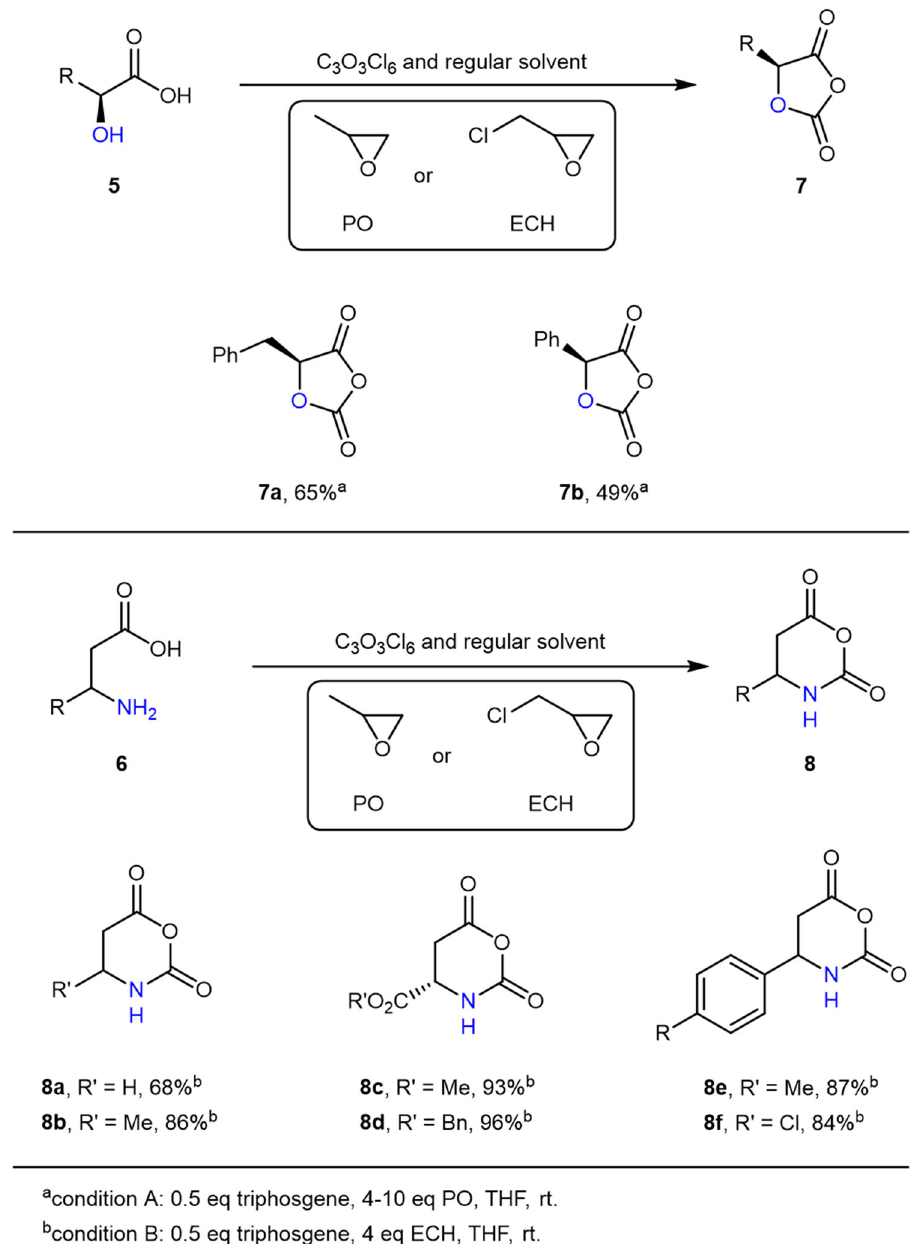
Fig. 6 Synthesis of β NCAs and OCAs. The addition of PO (propylene oxide) or ECH (epichlorohydrin) enables the facile synthesis of β NCAs and OCAs without the need of dry solvents, Schlenk line, or glove